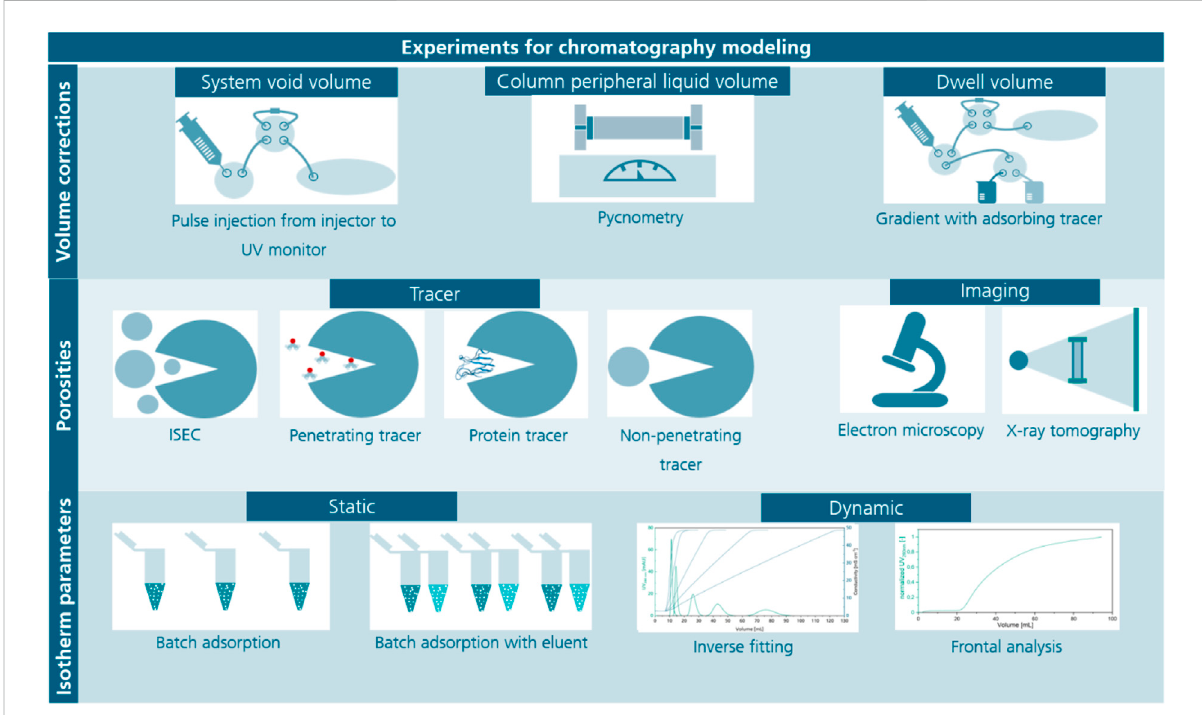
FIGURE 1 Overview of experiments for the determination of volume corrections of the chromatography system, porosities and isotherm parameters. Severalvolumecorrectionsduringchromatographymodelingarenecessary,herethemostcommonmethodsarelistedbeingpulseinjectionsusing an adsorbing tracer for the system void volume, pycnometry where the mass of the empty and water fi lled column is measured to determine the column peripheral liquid volume and the determination of the dwell volume using gradients with an adsorbing tracer while replacing the columnwithazero-volumeconnectororacapillaryrestrictor.Methodsforthedeterminationofporositiesareeitherasetofmethodsusingdifferent sized tracers, inverse size-exclusion chromatography (ISEC) or imaging methods such as electron microscopy or X-ray tomography, which require special equipment and complex evaluation. Tracers can be pore penetrating tracers or non-penetrating tracers either protein-based or synthetic. Lastly, methods for isotherm parameter determination mainly differ in static or dynamic approaches, which have individual advantages as suitability for screening (static) or high portion of information